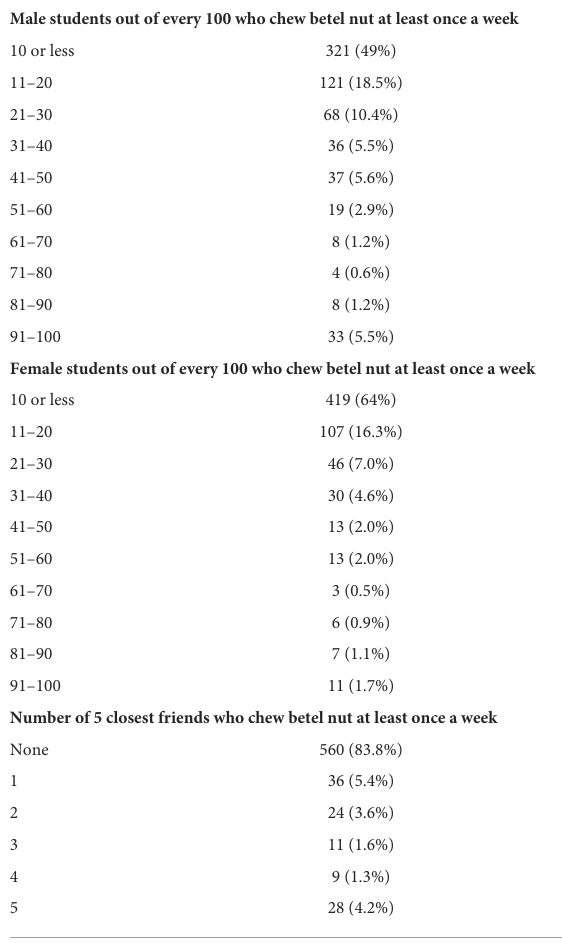
TABLE 2 Descriptive peer